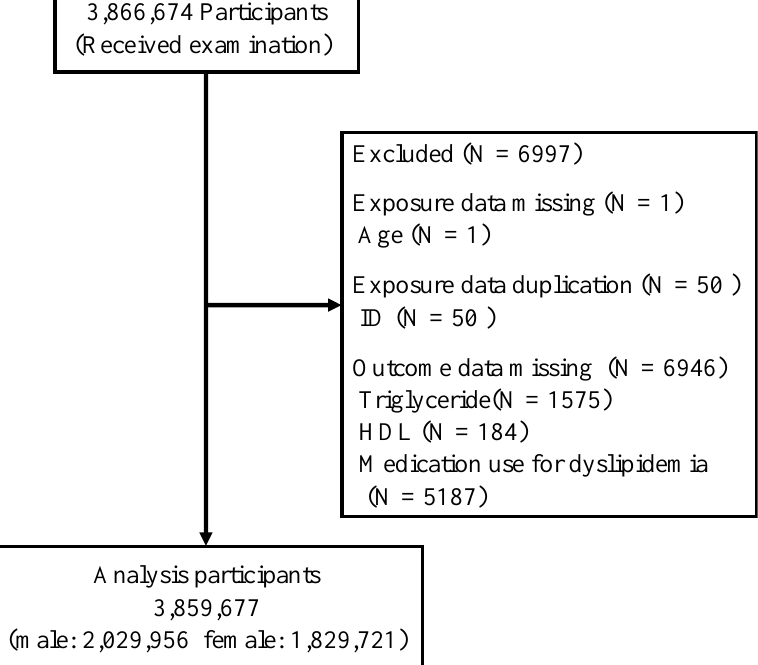
Figure 1. Flowchart of the target population. Total number of people included in the study analysis, with breakdown of the study cohort according to sex, within the total participants for whom data were obtained on specific health checkups for the ten-year period from fiscal year 2008 to fiscal year 2017.